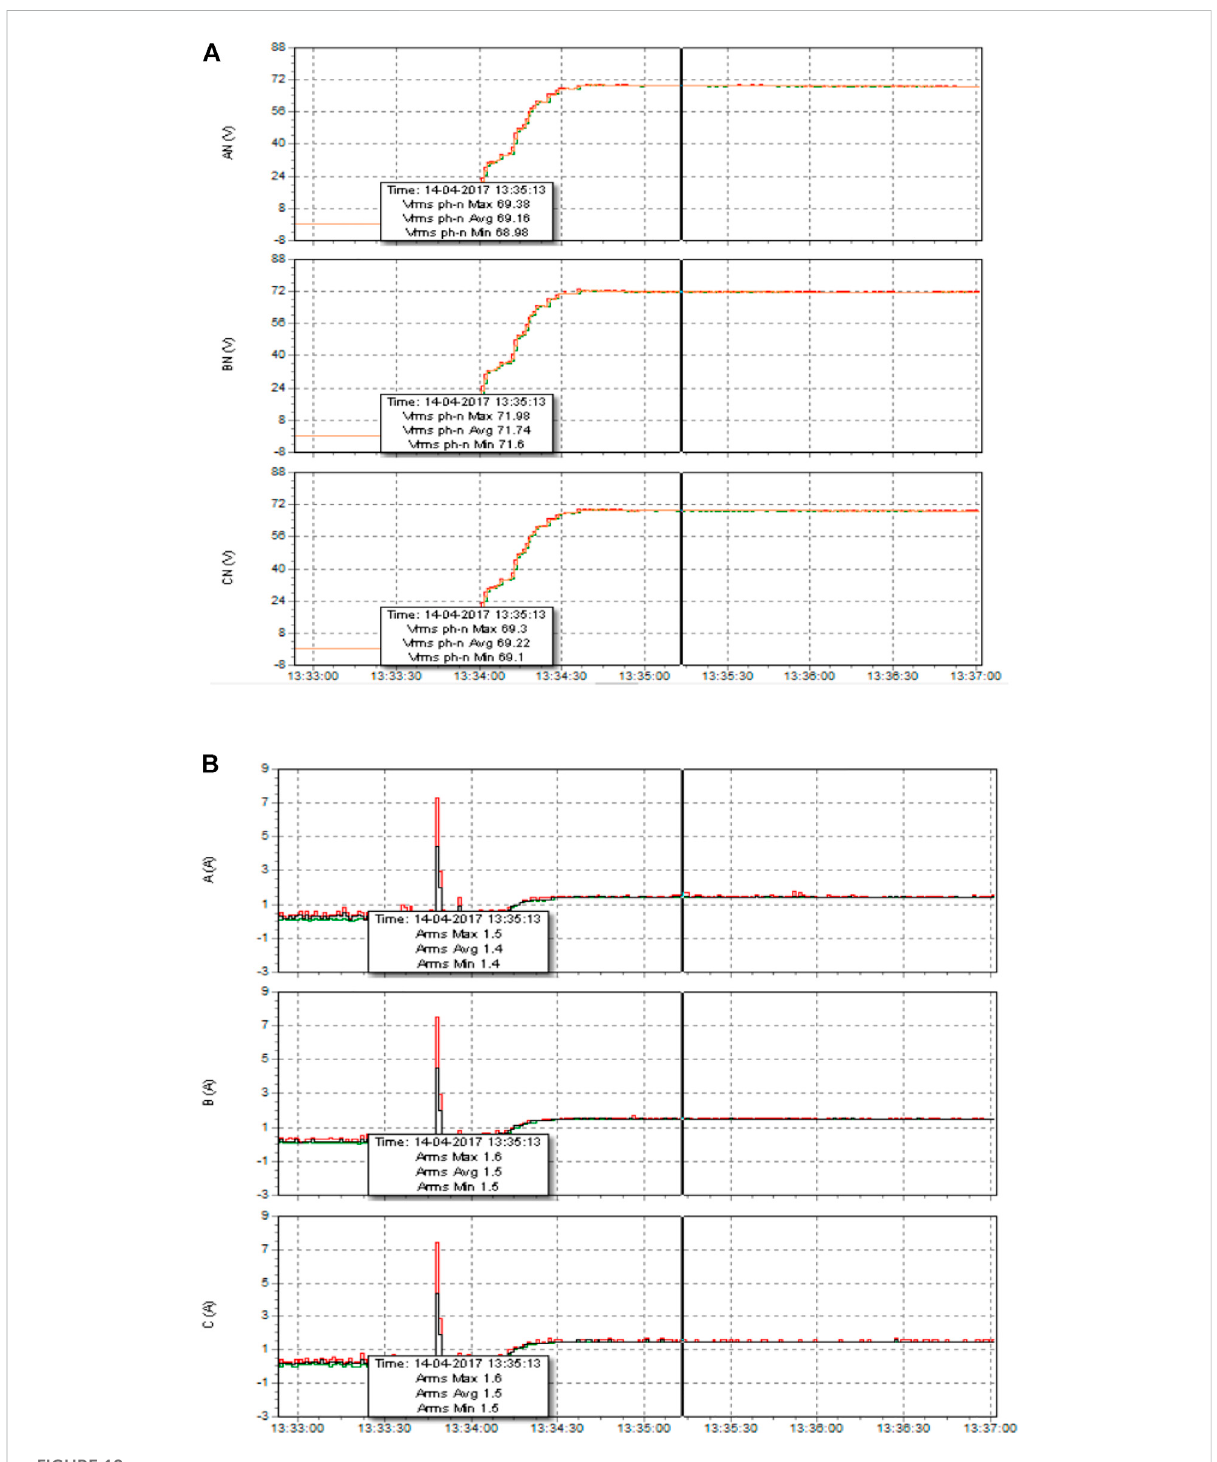
FIGURE 18 1HP, load 1 kg condition 120V with fi lter 24.7 Ω , 3 mH (A) voltage and (B)